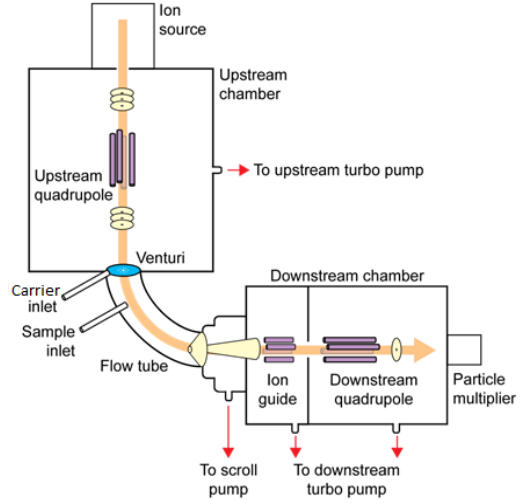
Figure 1. Schematic of a commercial Selected Ion Flow Tube-Mass Spectrometry (SIFT-MS) instrument from Syft Technologies Ltd showing the arrangement of the various components for the Voice200 model.